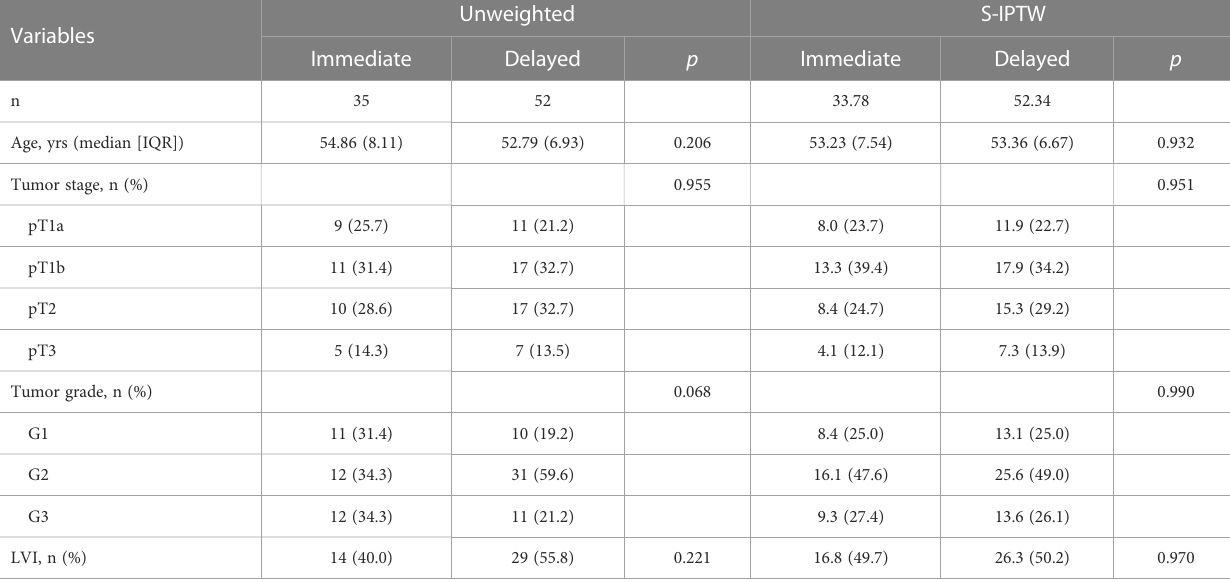
TABLE 2 Descriptive characteristics of 87 patients who underwent either immediate ILND or delayed ILND, with unweighted and S-IPTW adjustments.